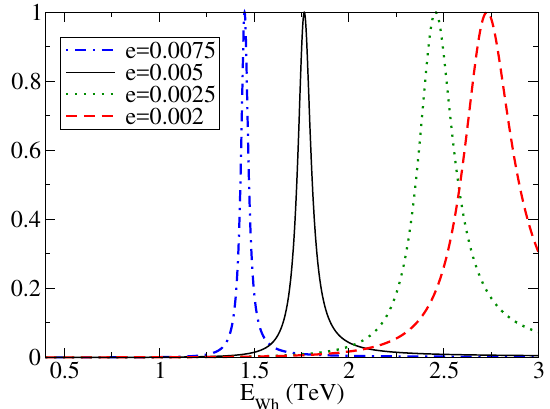
Figure 2 . The I = J = 1 axial resonance generated in V L h scattering by the e counterterm in the NLO HEFT Lagrangian, with values of the constant at µ = 3 TeV as indicated in the legend. Here, d = 0, a = 0 . 95 and b = 0 . 7 a 2 are fixed.